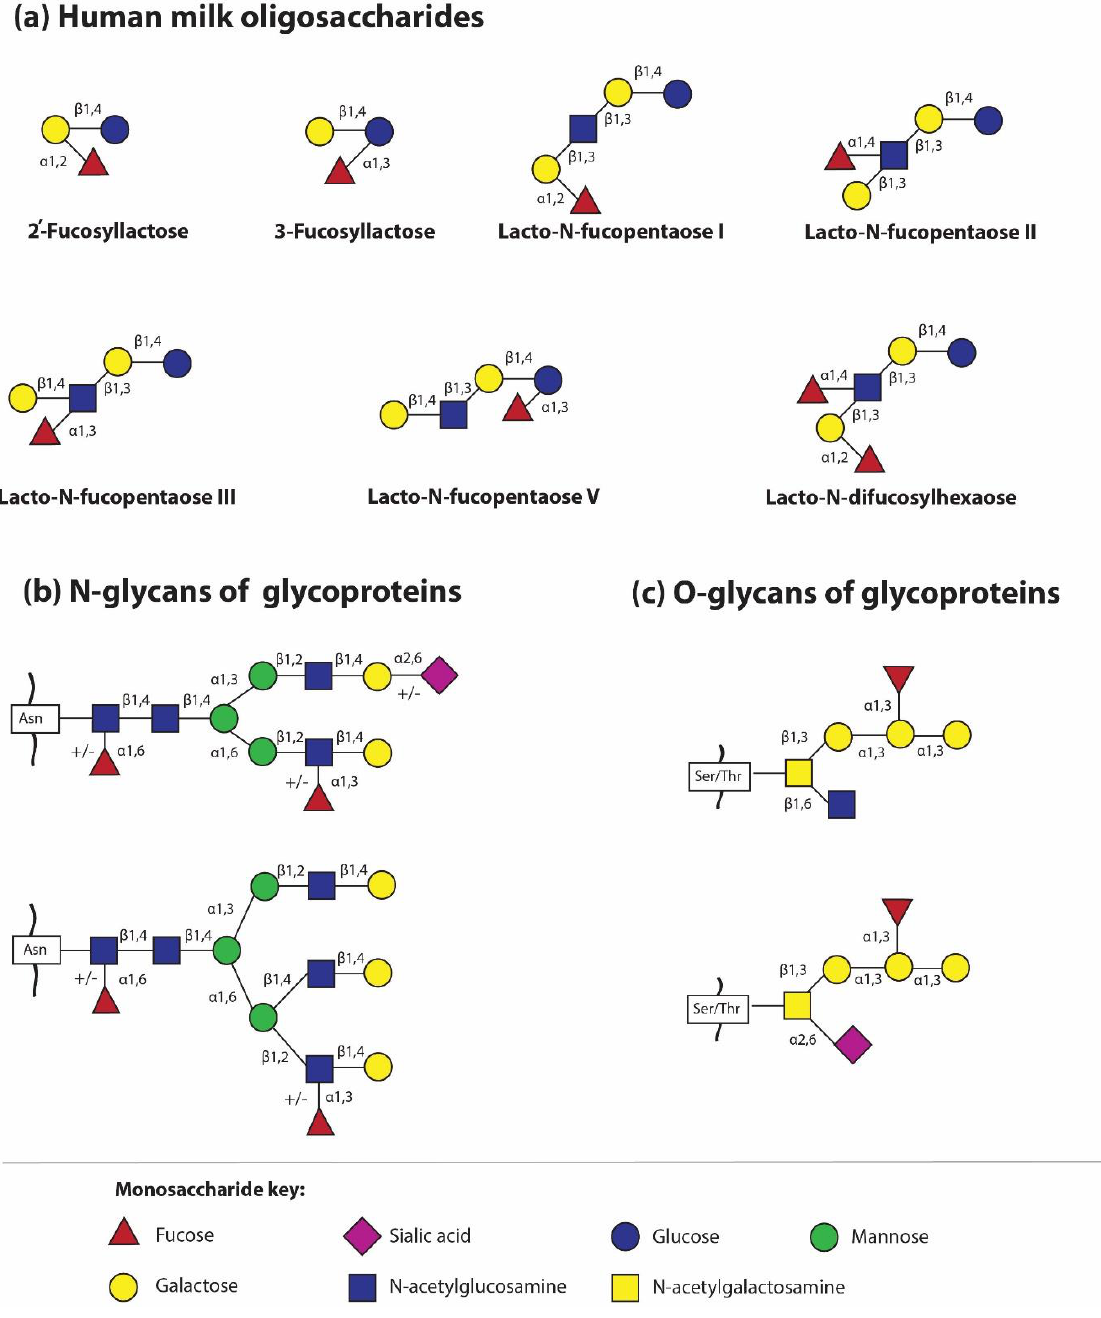
Figure 1. The main fucosylated structures of human milk oligosaccharides and glycans attached to glycoproteins [49–51]. ( a ) The most abundant fucosylated human milk oligosaccharides; ( b ) fucosylated N-glycans of glycoproteins – the two most common fucosylated structures in human milk N-glycome are presented [52,53]; Asn – asparagine; and ( c ) fucosylated O-glycans of human milk glycoproteins [52,53]; Ser – serine, Thr – threonine.